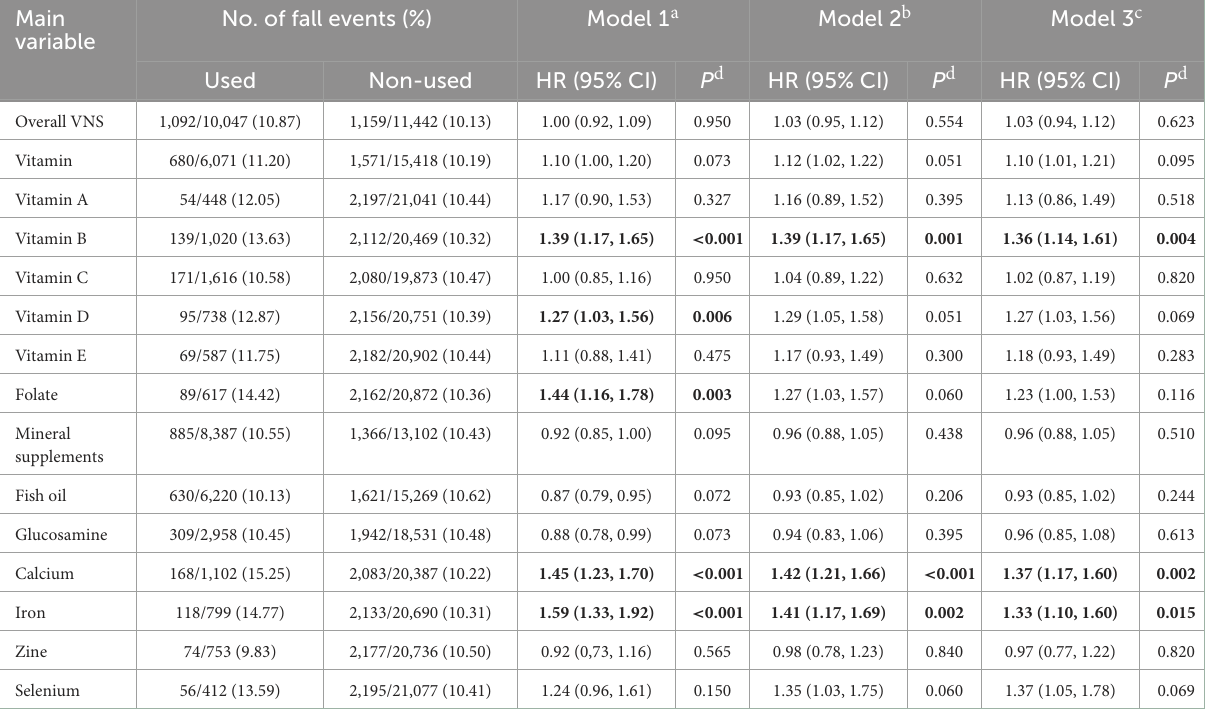
TABLE 3 Associations of overall VNS and specific VNS with the risk of fall in UK Biobank. Main